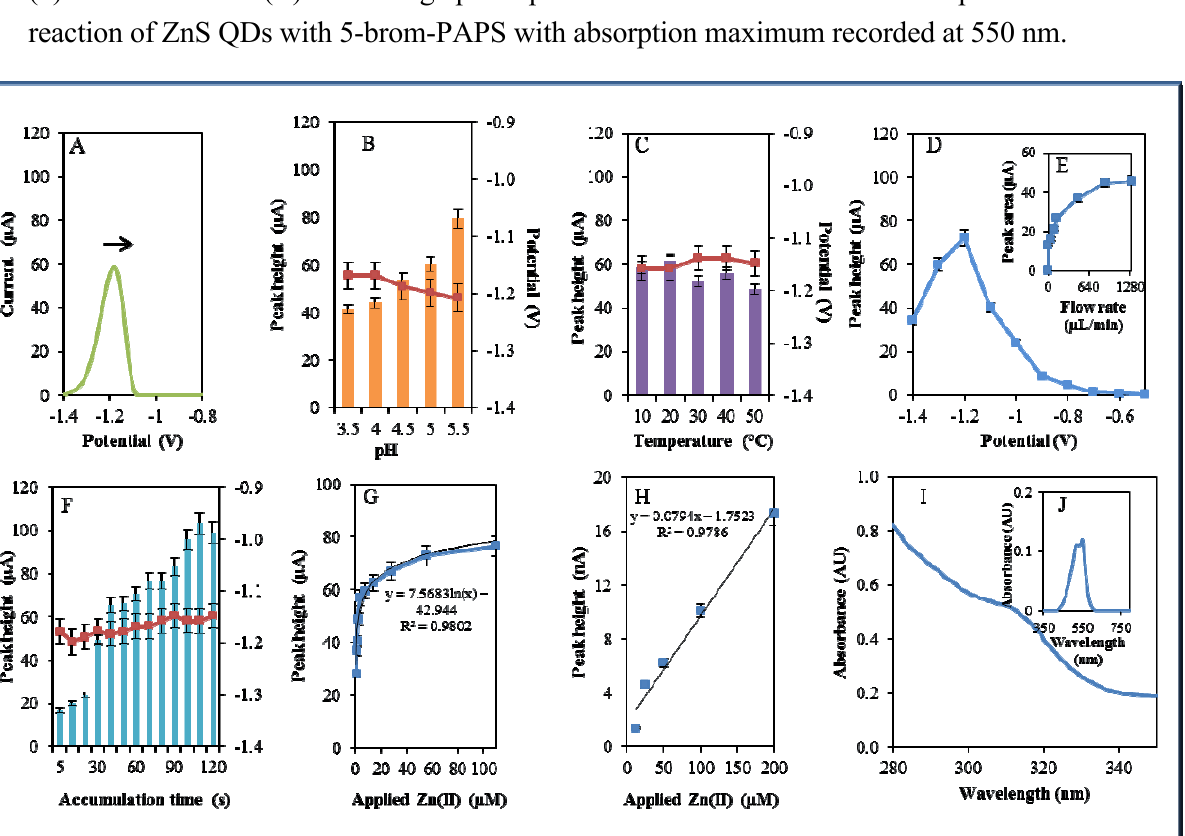
Figure 7. Electrochemical and spectrophotometric analysis of ZnS QDs. Basic